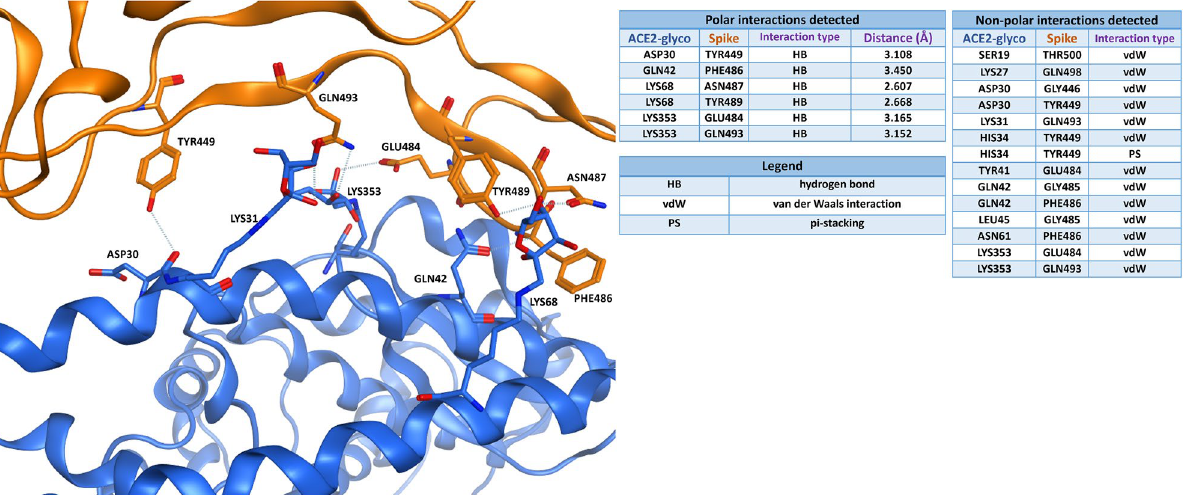
Figure 4. Viral Spike protein RBD (PDB: 6M0J, orange-colored) is binding to glycated ACE2 receptor (blue). The tables on the right report the polar and the non-polar interactions in which the residues on the interface are involved. For the polar interactions, also the distance between the interacting atoms (measured in angstroms) is reported in the table. To get a better visual representation of the contacts, just the residues engaged in the polar interactions are labelled in the 3D image on the left, while all the non-polar interactions are omitted.